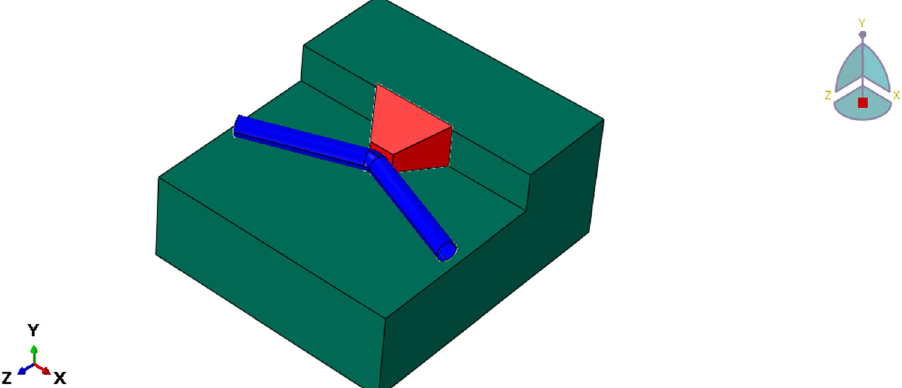
Figure 16: General view of Case 4.